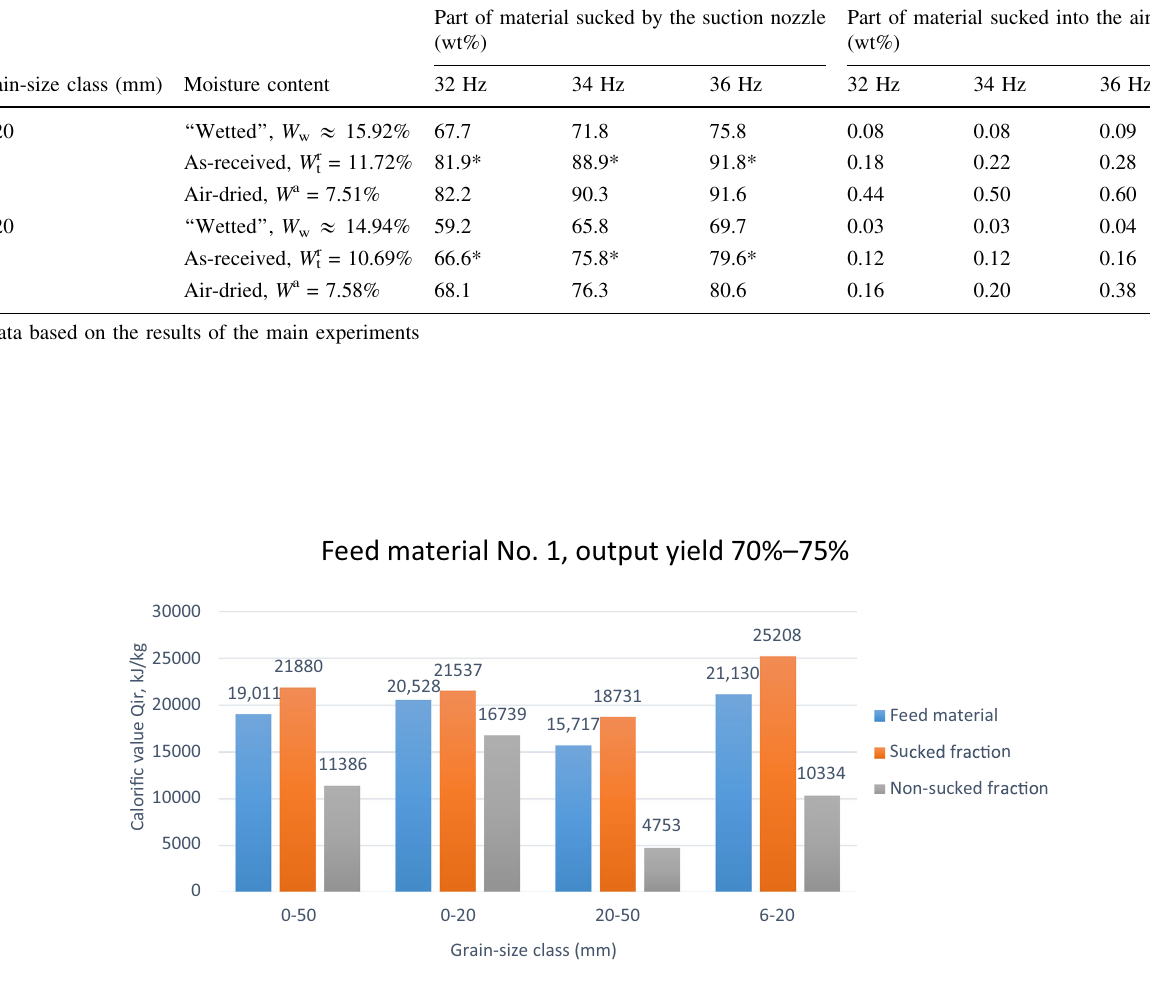
Table 9 Effects of feed moisture content on the suction efficiency and dust collector load